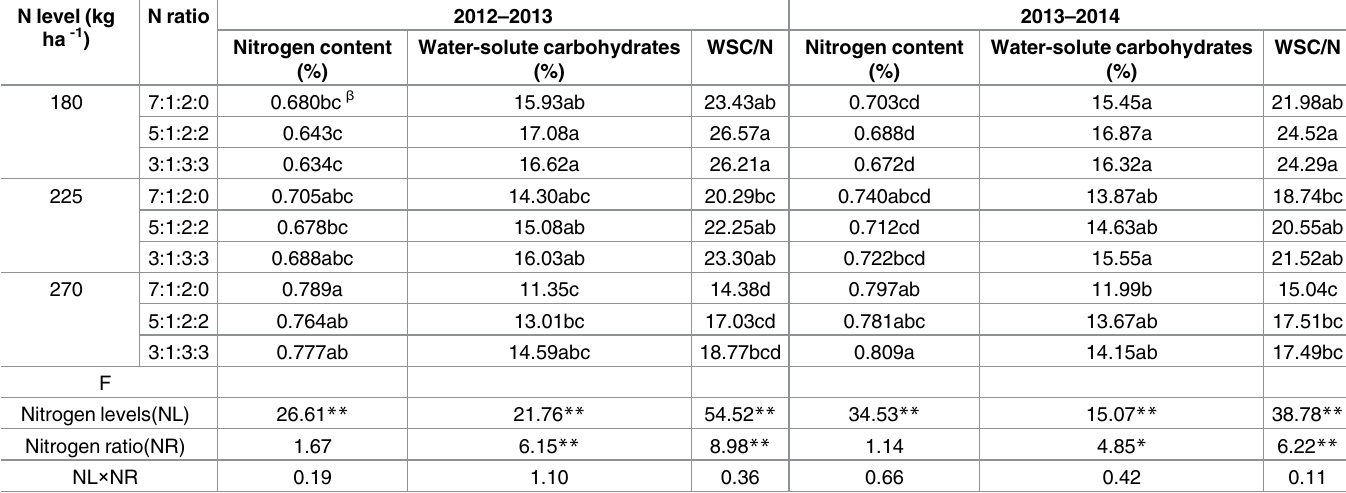
α WSC/N: the ratio of water-solute carbohydrates to nitrogen β Values in a column followed by the same letter are not significantly different at P < 0.05 as determined by the LSD test. The test was conducted separately between the two